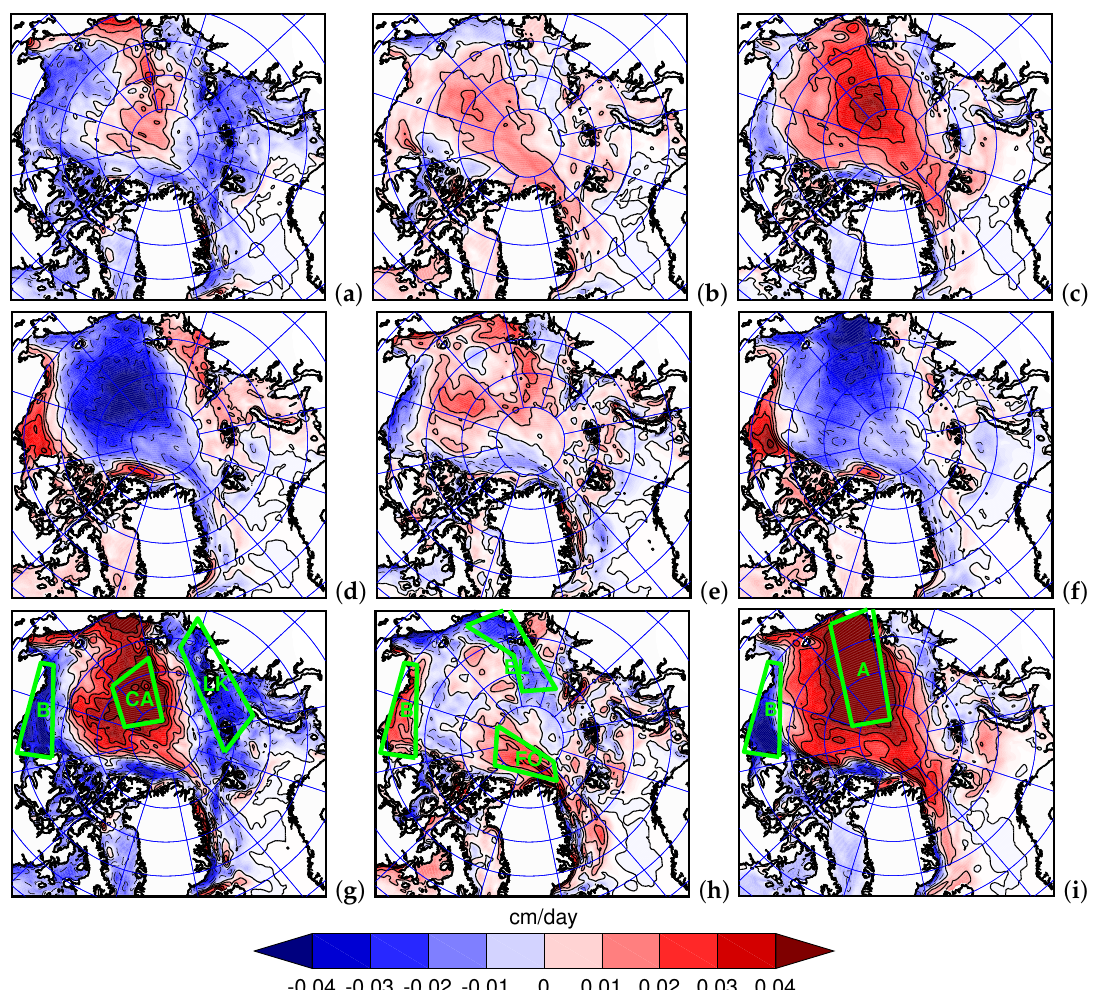
Figure 5. Ice growth rates (cm/day) associated with the first ( a , d , g ), second ( b , e , h ) and third ( c , f , i ) EOF modes of the surface wind decomposition: ( a – c ) the weighted average value of the growth rate for the periods of positivity of the principal components of the decomposition, ( d – f ) the weighted average value of the growth rate for the periods of negativity of the principal components, ( g – i ) the difference of the weighted average of the positive and negative phases (( g − − i ) = ( a − − c ) − ( d − − f )) . In the figures ( g – i ), the areas of the highest dynamic growth and the largest decrease for different modes are marked: (A) the central Arctic and the East Siberian Sea, (B) the shelf of the Beaufort Sea, (CA) the central Arctic, (EL)—East Siberian Sea and the Laptev Sea, (FO)—the Fram Strait outflow area, (LK)—Laptev Sea and the Kara Sea. (Latitudes: interval—5 degrees, maximum is 85 N. Longitudes: interval—30